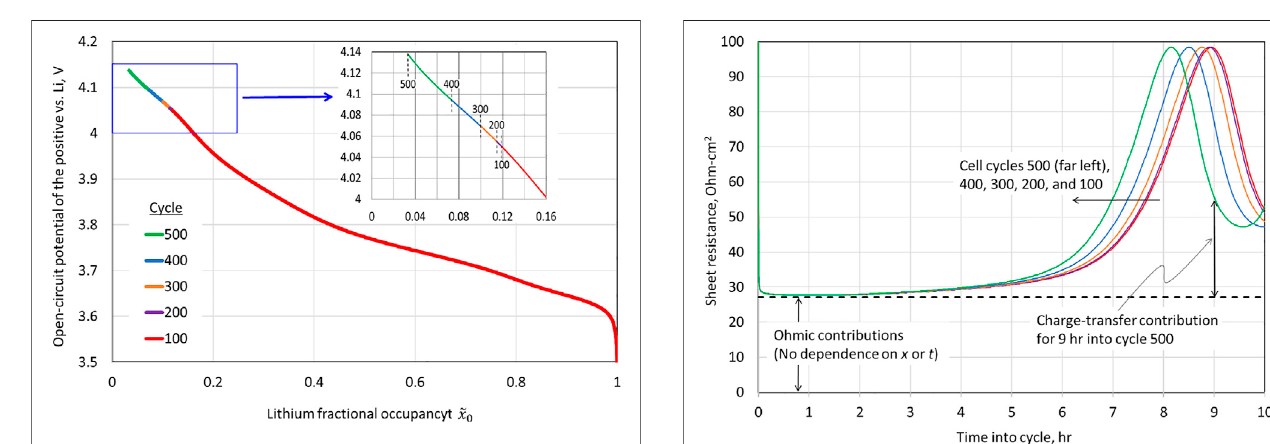
FIGURE11| Regressedcellresistance(cf. Eq.73 ).Ohmiccontributions (see R ohmic de fi ned in Eq. 73 ) dominate for the fi rst half of the charge (0 – 5